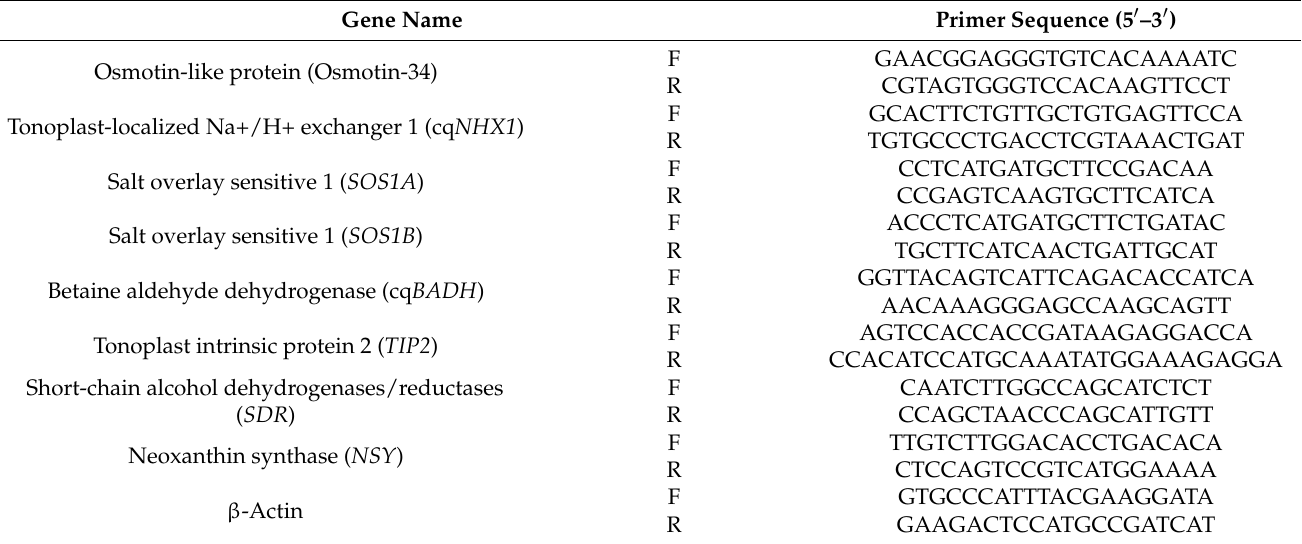
Table 1. The sequences of the primers used in